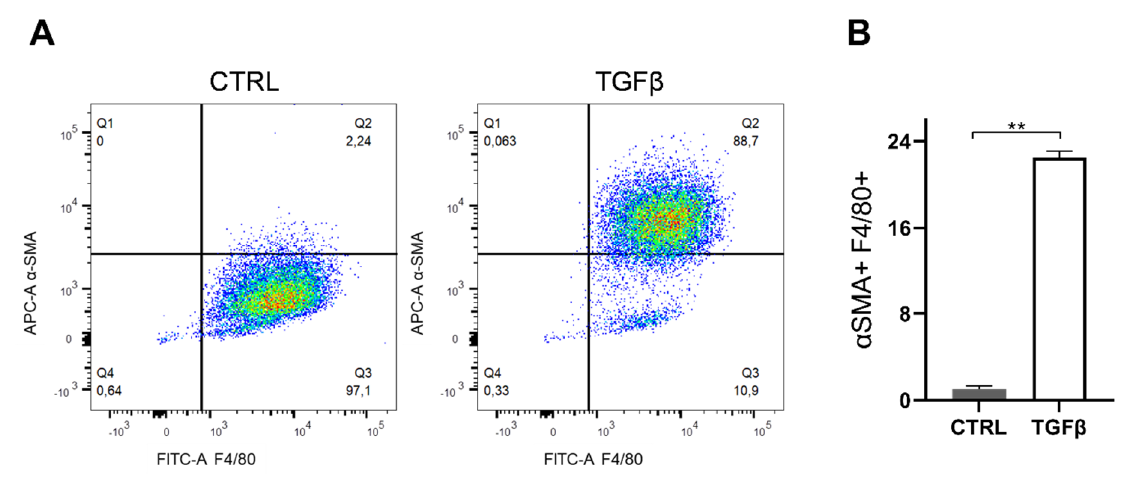
Figure A3. TGF β stimulation on i µ Φ leads to increase of α SMA. ( A ) Gating strategy for the expression of the macrophage marker anti-F4/80-FITC and the myofibroblast marker α SMA-APC by flow cytometry in i µ Φ after a 5 day treatment with TGF β (5 ng/mL). Unstimulated i µ φ were used as a control (CTRL). ( B ) Quantification of the α SMA + cell population ( n = 3). Data are means ± SEM. ** p < 0.01.